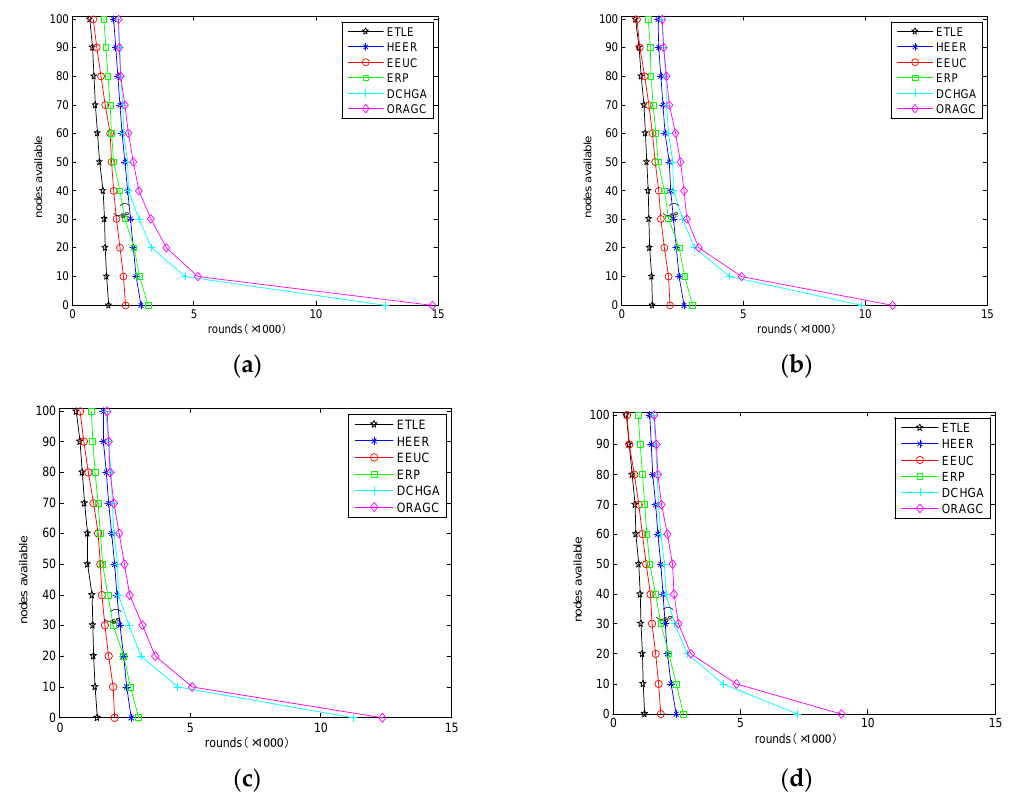
Figure 3. ( a ) Energy consumption of the routing algorithms in scenario 1. ( b ) Energy consumption of the routing algorithms in scenario 2. ( c ) Energy consumption of the routing algorithms in scenario 3. ( d ) Energy consumption of the routing algorithms in scenario 4.